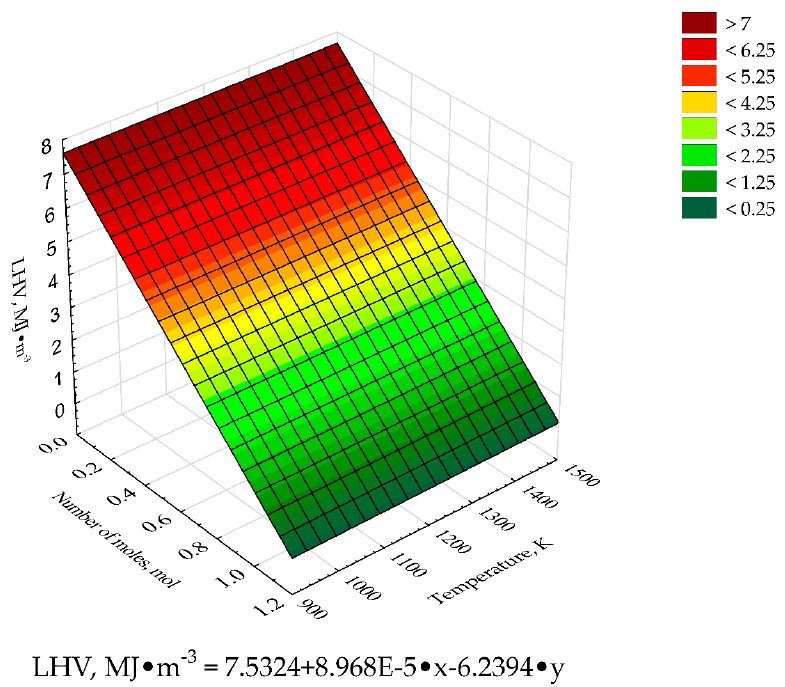
Figure 7. The effect of the number of moles of the gasification agent air (x) and temperature (y) on the heating value ( LHV ) of syngas.